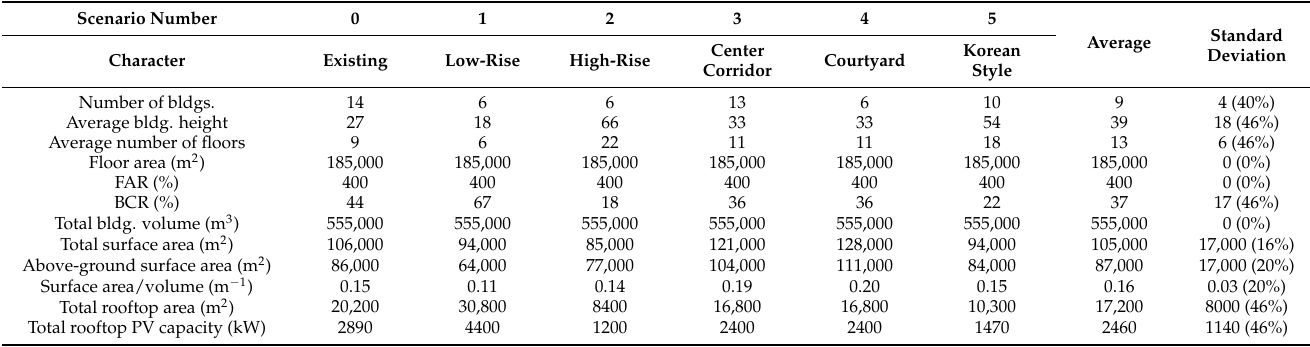
Figure 6. Existing buildings and five scenarios. ( a ) Scenario 0: existing buildings, ( b ) Scenario 1, ( c ) Scenario 2, ( d ) Scenario 3, ( e ) Scenario 4, and ( f ) Scenario 5. All the scenarios have the same FAR. Numbers next to buildings are building identification numbers. Table 2. Characteristics of district scenarios. For the calculation of “surface area/volume”, “above- ground surface area” was used. Numbers in parentheses were calculated by standard deviations divided by averages. See also Figure 5 for 3D building representation of the scenarios. Bldg. is an abbreviation for building.